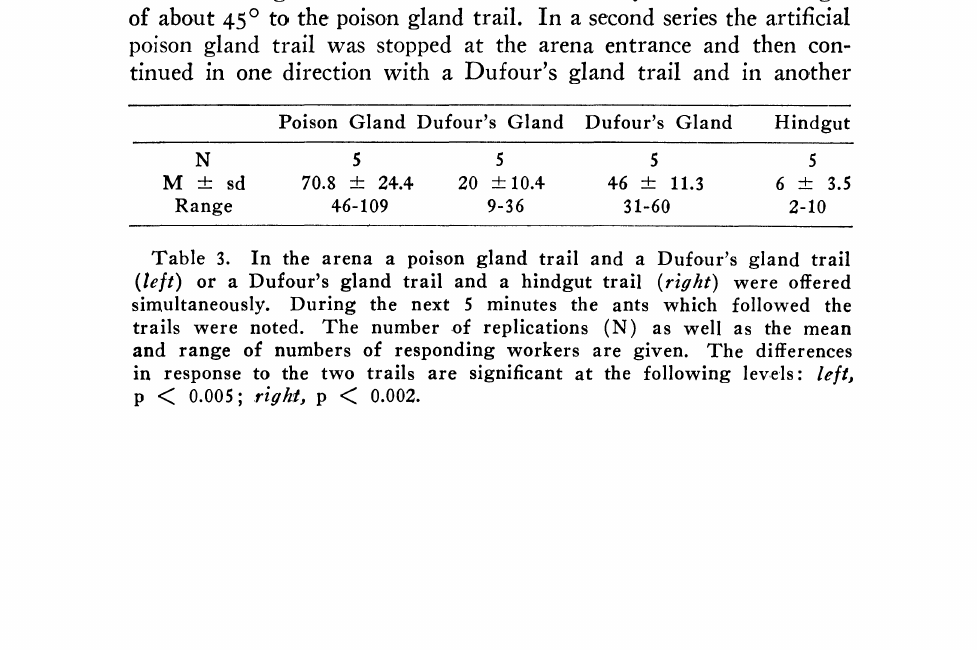
Fig. 6c. The progress of recruitment and foraging activity at oak flakes widely dispersed. Details as in caption of fig. 6a.